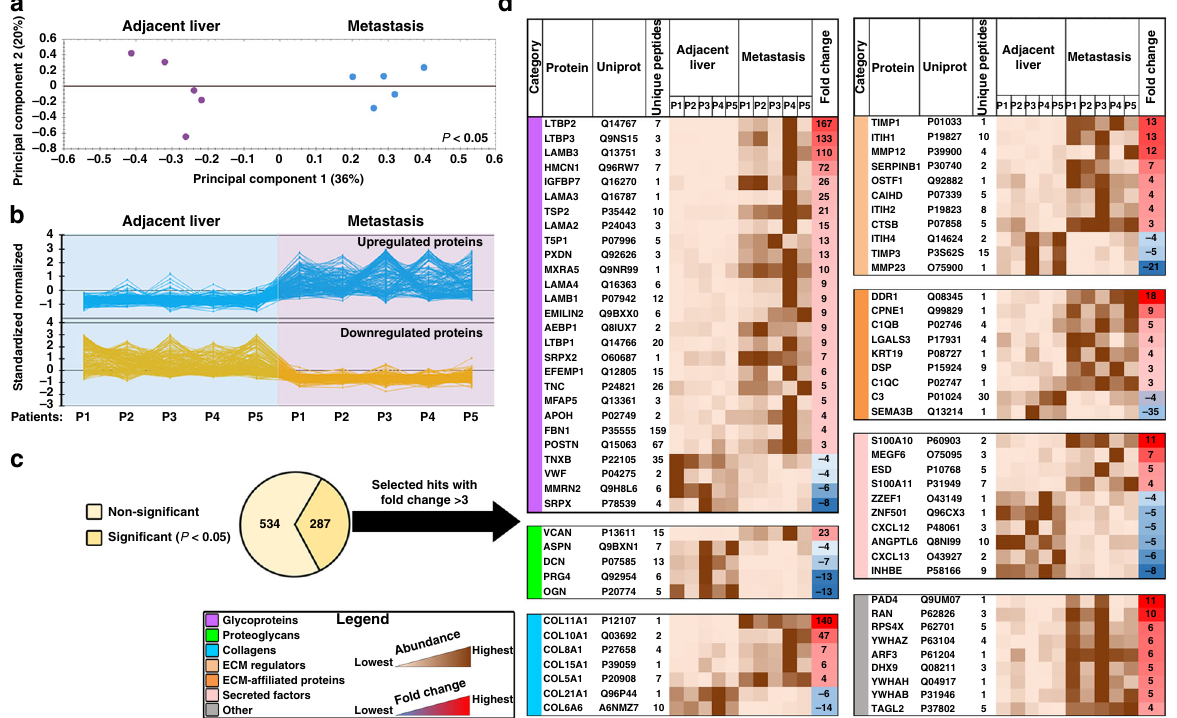
Fig. 1 Label-free quantitative proteomics identi fi es the distinctive ECM composition of human CRC hepatic metastases. a Decellularized and ECM-enriched fractions from CRC hepatic metastases and paired adjacent unaffected liver tissues ( n = 5 per group) were analyzed using LC-MS/MS with the following label-free quantitation. Shown is the principal component analysis of the relative protein abundance between metastasis and adjacent liver groups ( P < 0.05). Percentage of variance is shown in parentheses. b Clustering analysis graph reveals categories of proteins differentially expressed in metastasis and adjacent liver groups. c Statistically signi fi cant differentially expressed proteins (287 out of 821 hits, two-way ANOVA, P < 0.05) were further classi fi ed either as ECM proteins or other proteins. d A heat map illustrating signi fi cantly different matrisome proteins (69 hits), which were selected based on a fold change threshold of > 3 and ranked in accordance with ECM category and fold change. The last gray colored table represents 9 selected other hits (i.e., non-ECM proteins yet signi fi cantly different in ECM-enriched samples). ECM extracellular matrix, P